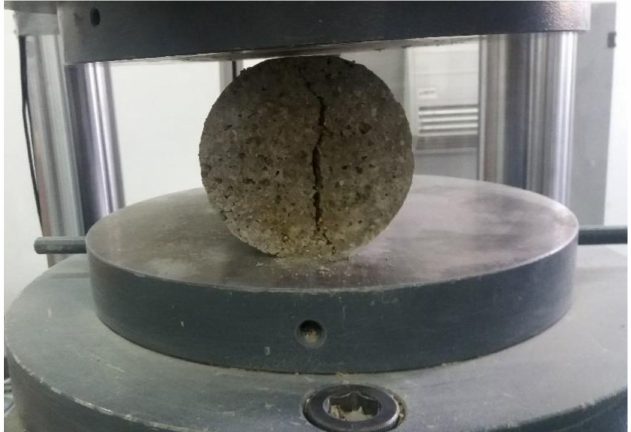
Figure 5. Splitting tensile